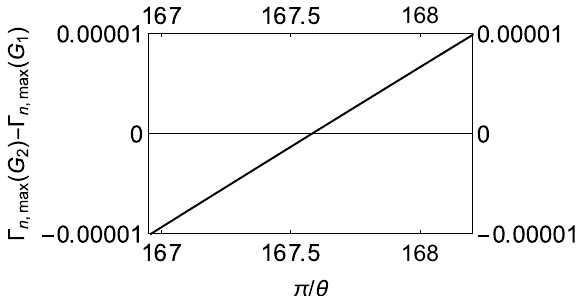
Figure 7. Difference between the maxima of the modified decay rates corresponding to G 1 and G 2 against π/θ .